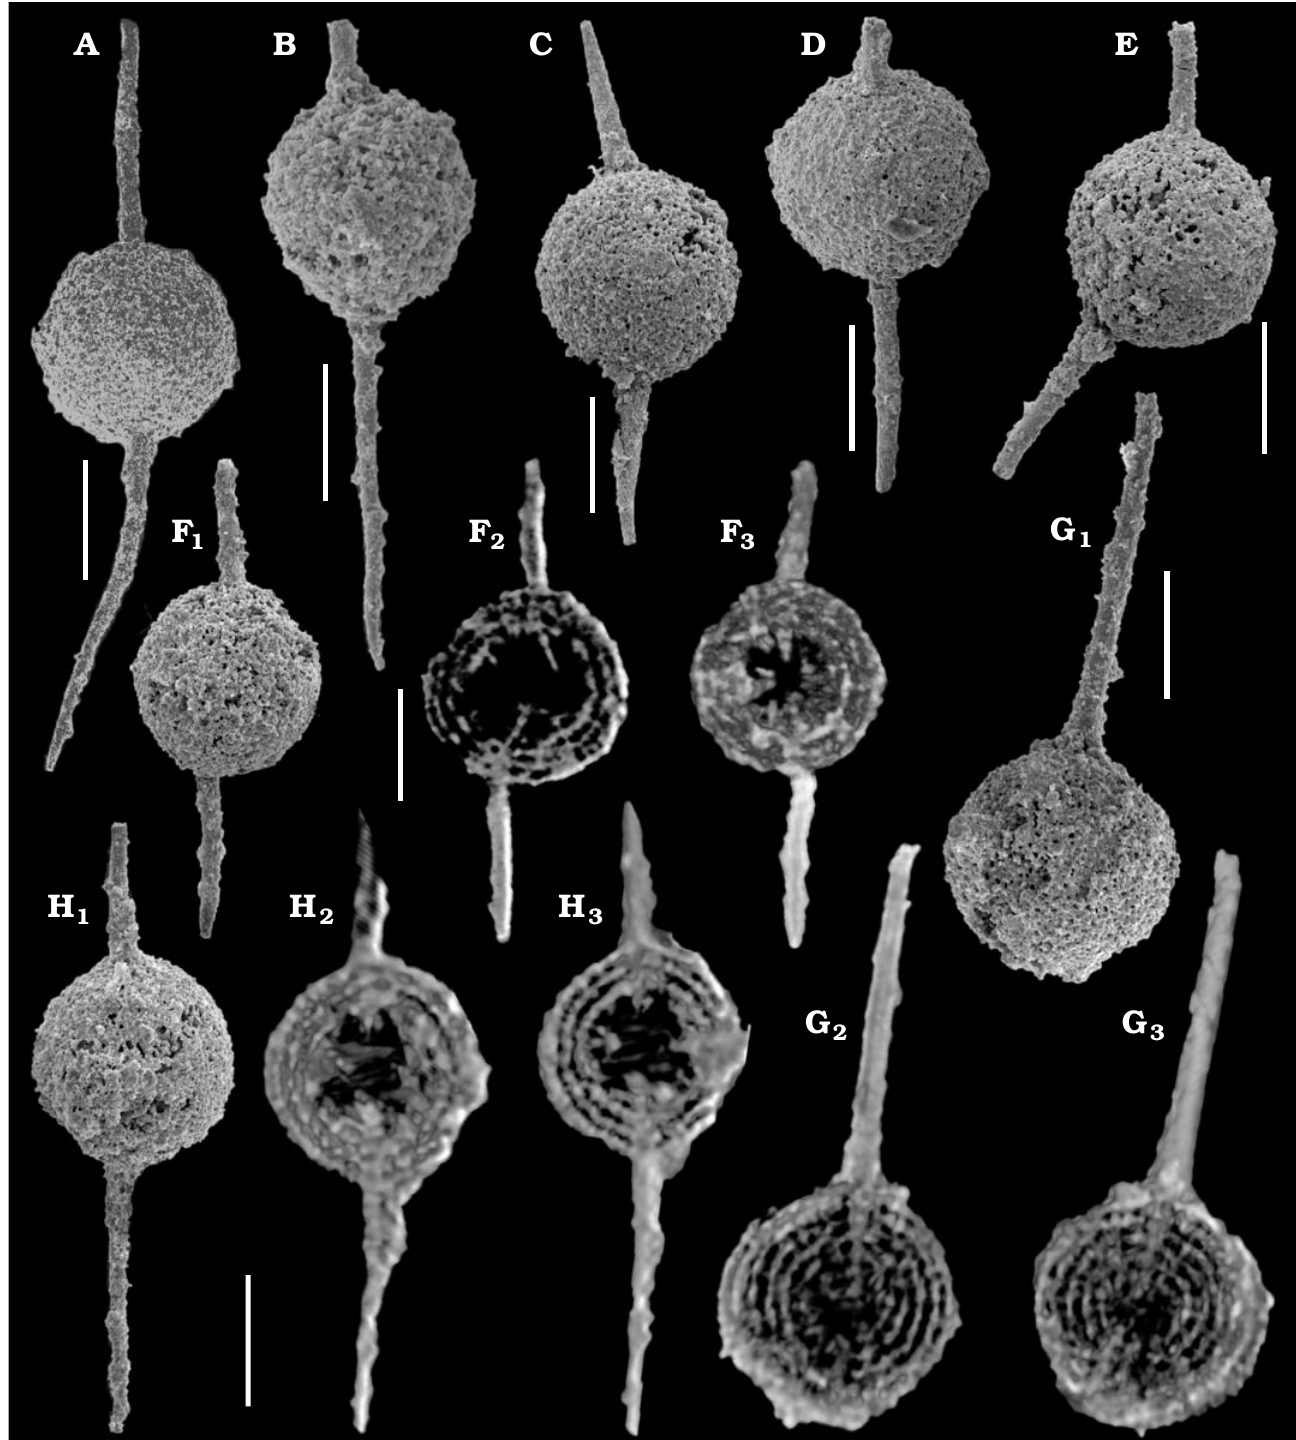
Fig. 1. SEM micrographs (A–E, F 1 , G 1 , H 1 ) and micro-XCT cross-sectional images (F 2 , F 3 , G 2 , G 3 , H 2 , H 3 ) of the polycystine radiolarian Dalongicaepa bipolaris Xiao and Suzuki gen. et sp. nov. from Changhsingian of the Rencunping section, South China. A . LGFEC SR 69-028 (paratype). B . LGFEC (holotype). Different cross sections show clear concentric shells which are connected with radial beams (F 2 , F 3 , G 2 , G 3 , H 2 , H 3 ). Scale bars 100 μ spherical hollow without a latticed spherical shell. Two Diagnosis. —Spongy cortical shell of spherical to fusiform significant bi-polar spines are present: cylindrical and no shape. Spongy tissue comprised with four to seven densely concentric shells. Central part of the cortical shell large blades. The proximal end of the spine is embedded into the